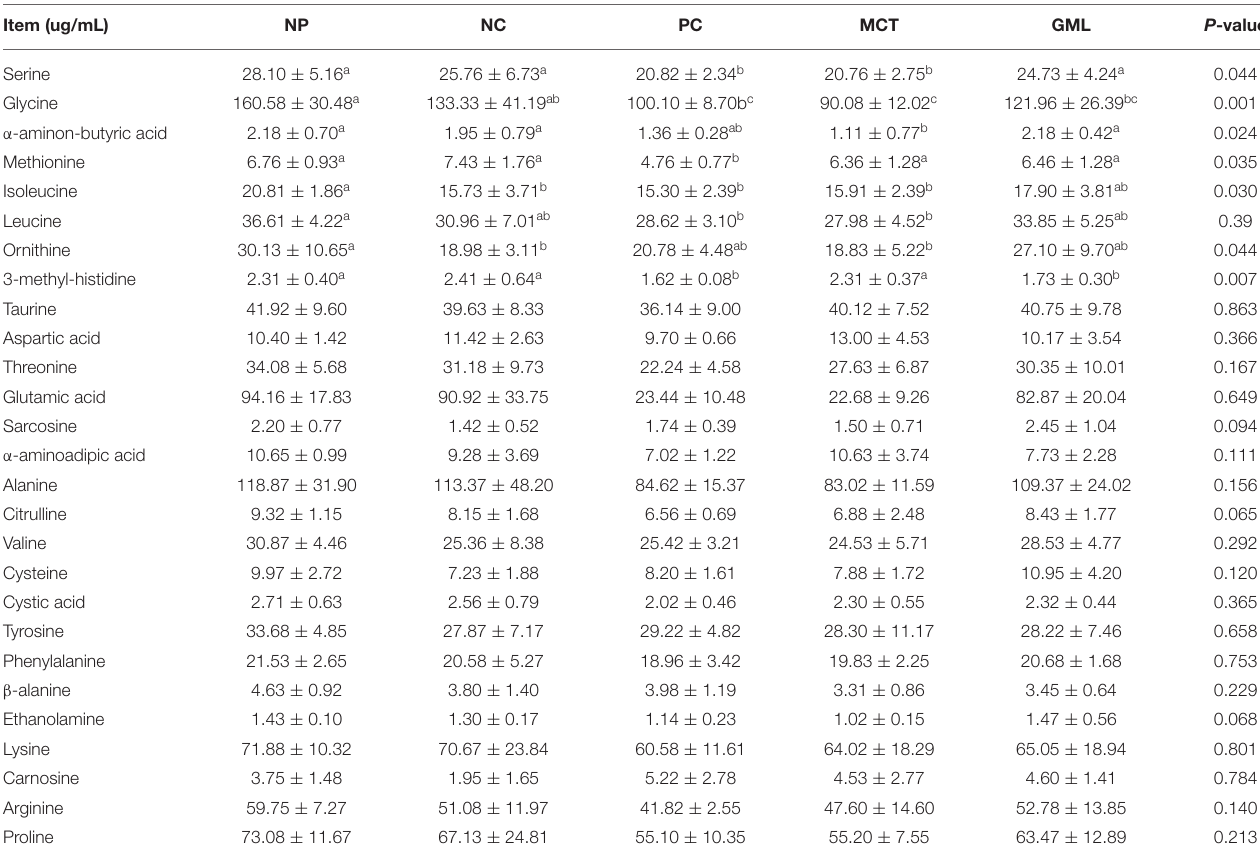
TABLE 3 | Effect of medium-chain fatty acid glycerides supplementation on serum free amino acids of piglets ( µ g/mL). Item